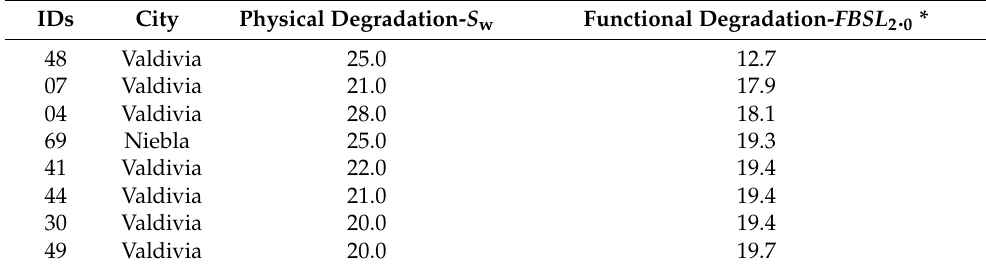
Table 8. Classification of eight case studies, which have achieved the end of their physical and functional service life.